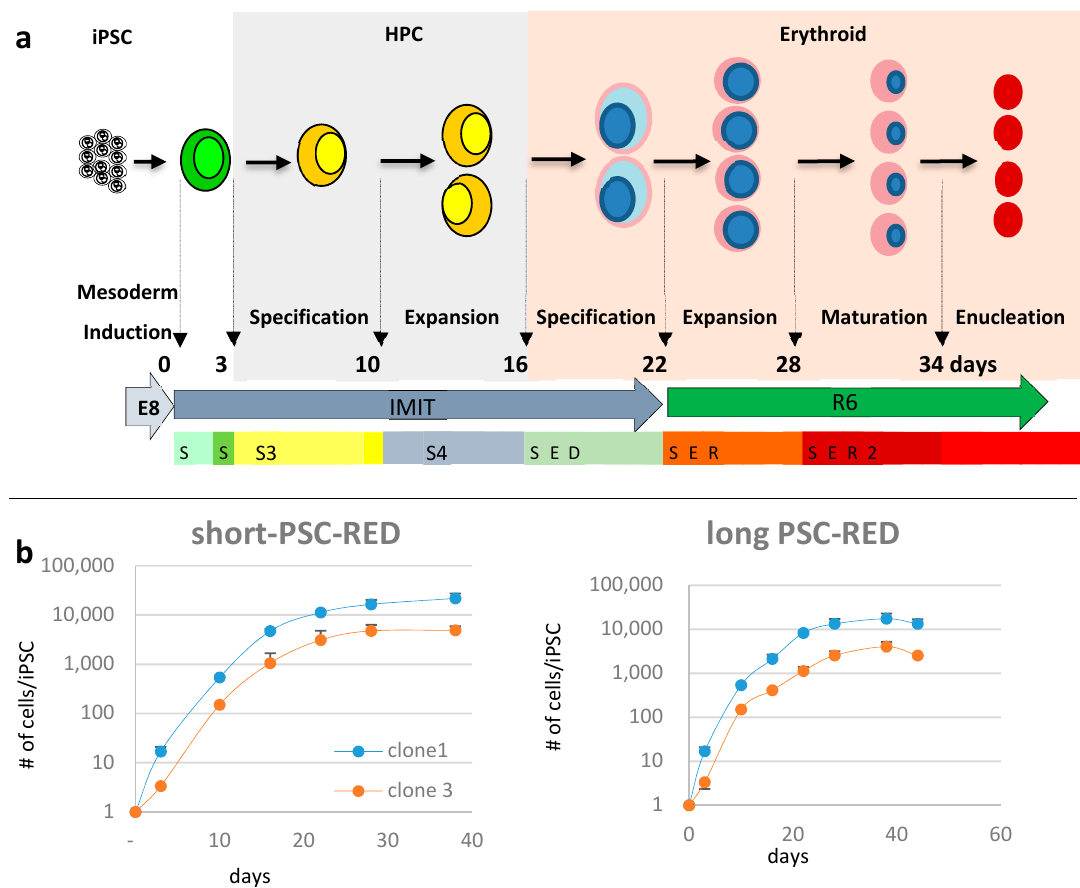
Figure 2. PSC-RED protocols: ( a ) Scheme illustrating the long PSC-RED protocol to produce enucleated cultured RBCs (cRBCs) from iPSC. In the short version of the protocol, the expansion step in S4 from day 10 to day 16 is omitted. Media and cytokine supplements are described in the Methods section; ( b ) graphs illustrating the number of cRBCs / iPSCs observed during the erythroid di ff erentiation of two di ff erent baboon iPSC clones (clone 1 and clone 3) using the short or long PSC-RED protocols. Data are expressed as average ± SEM of 3 independent experiments.